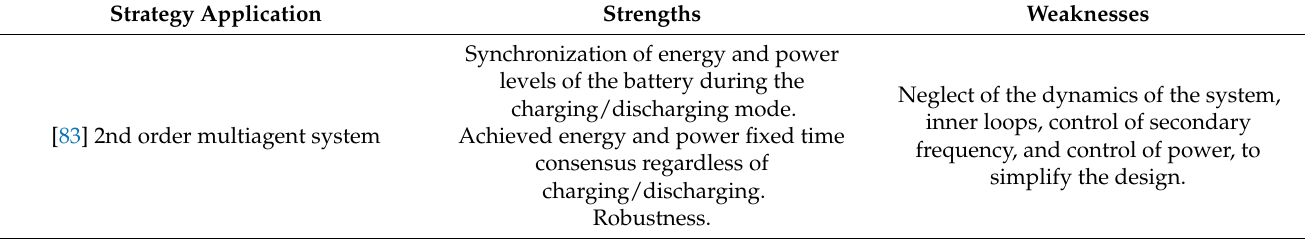
Table 3. Summary of distributed multiagent control